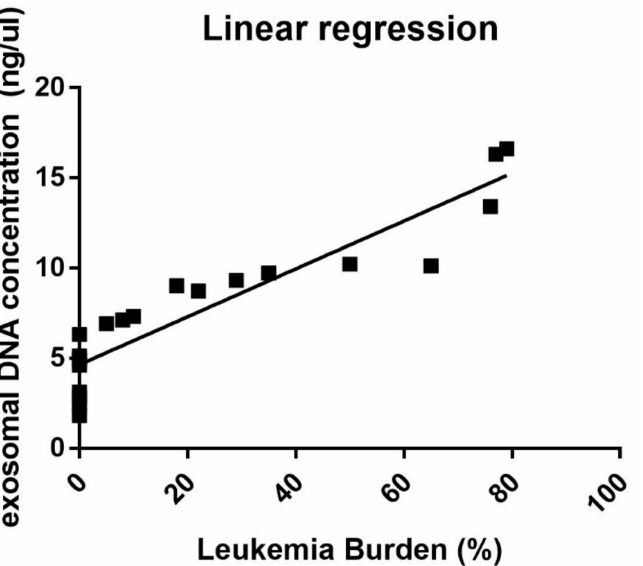
Figure 1. Linear regression analysis between leukemia burden estimated by cytofluorimetric analysis and exosomal DNA concentration expressed in ng/ µ L.